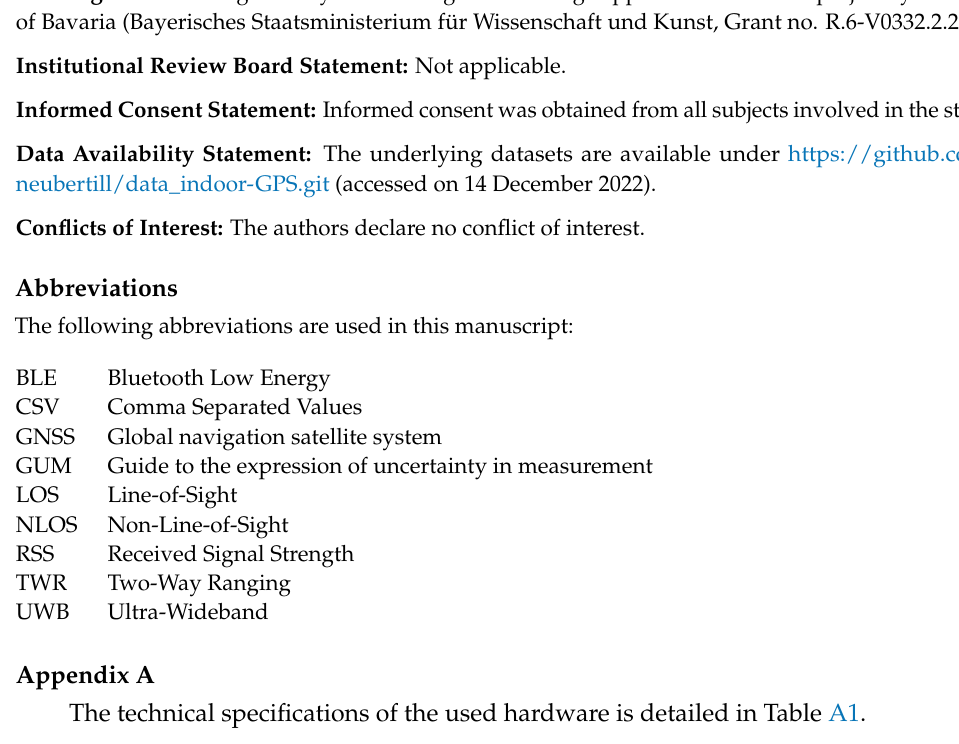
Table A1. Technical